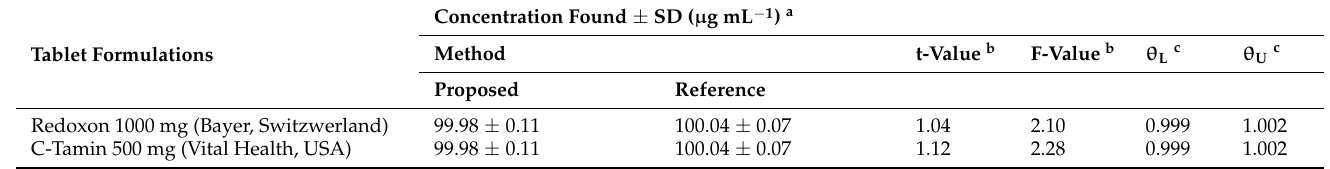
Table 8. Significance of testing between the proposed HPLC and reference methods at 100 µ g mL − 1 of active ascorbic acid in tablet formulations at 95% confidence